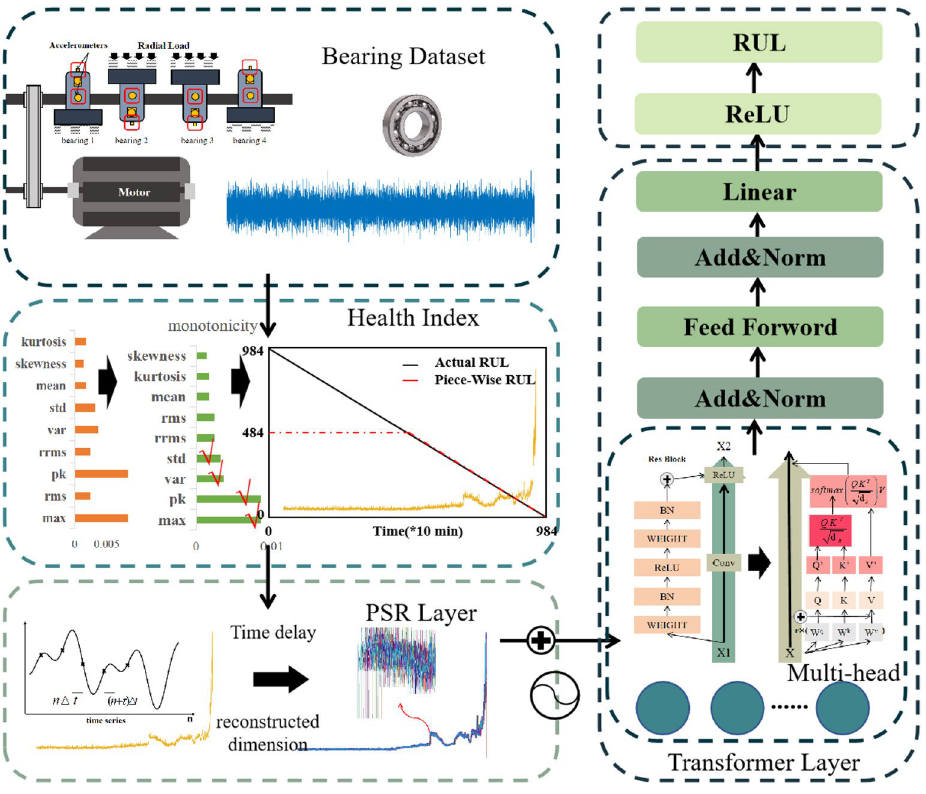
Figure 1. Flowchart of RUL prediction